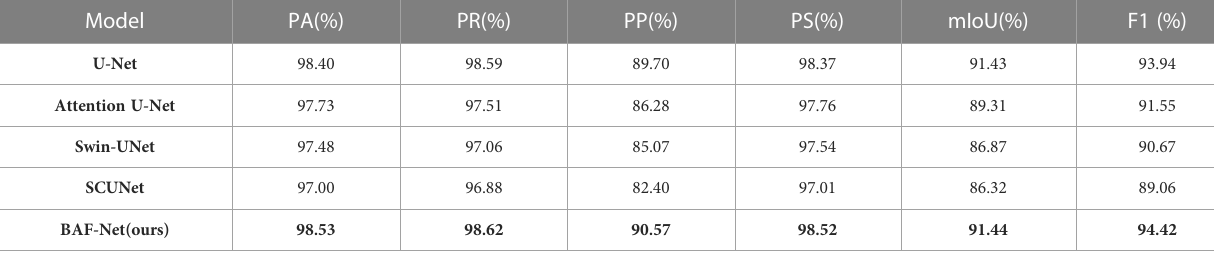
TABLE 6 The segmentation results on the pepper leaf dataset using different models. Model